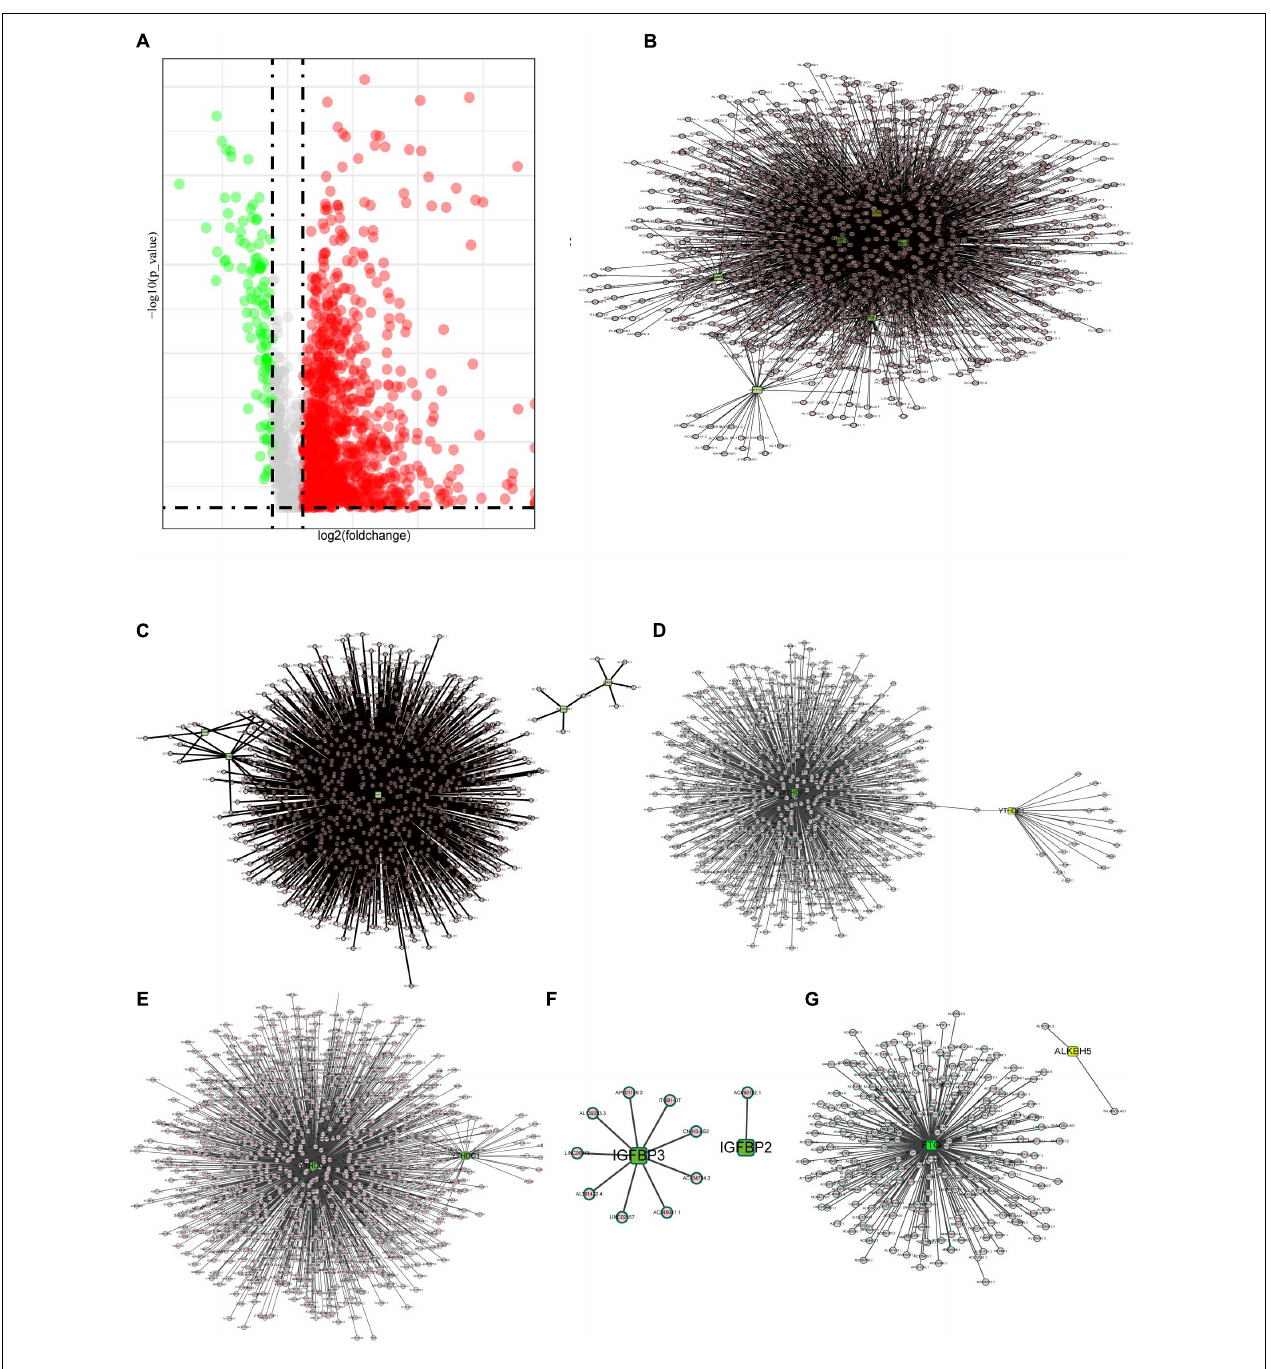
FIGURE 2 | Interactions and correlations between m6A RNA regulators and lncRNAs. (A) Volcano plot showing differential expression of lncRNA regulators in the TCGA-COAD cohort. (B) Pearson correlation analysis was used to search the relationship between m6A regulators and lncRNAs. The regulatory network between m6A writers and lncRNAs demonstrated by Cytoscape. (C–F) Correlation between m6A regulator readers and lncRNAs expression, highlighting the YTHDF, YTHDC, and IGFBP families. (G) The regulatory network between m6A erasers and